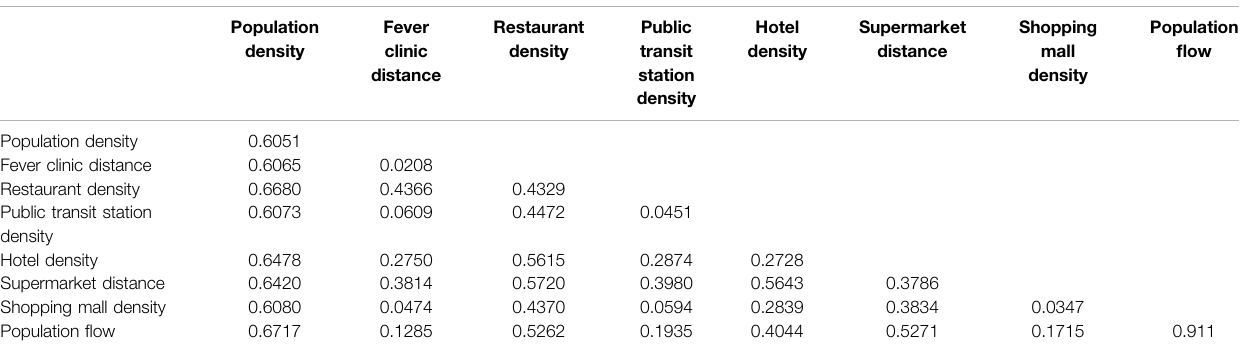
TABLE 3 | Interaction detector.